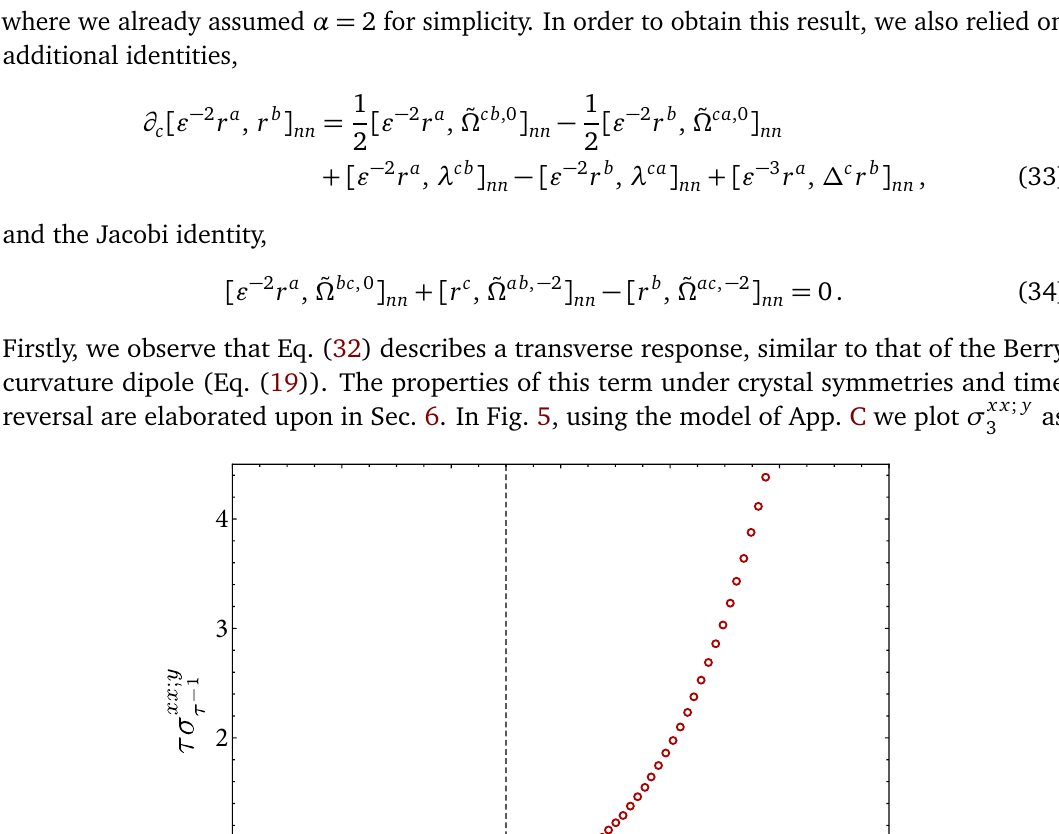
, and the result g ( µ ) = σ xx ; y ( − µ ) . This is explained in App. 3 3